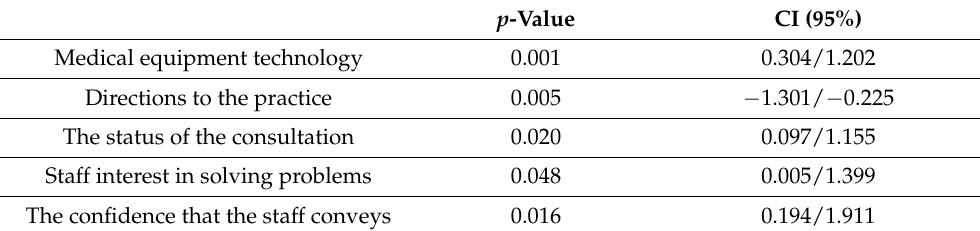
Table 2. Significant variables in the multivariate study.